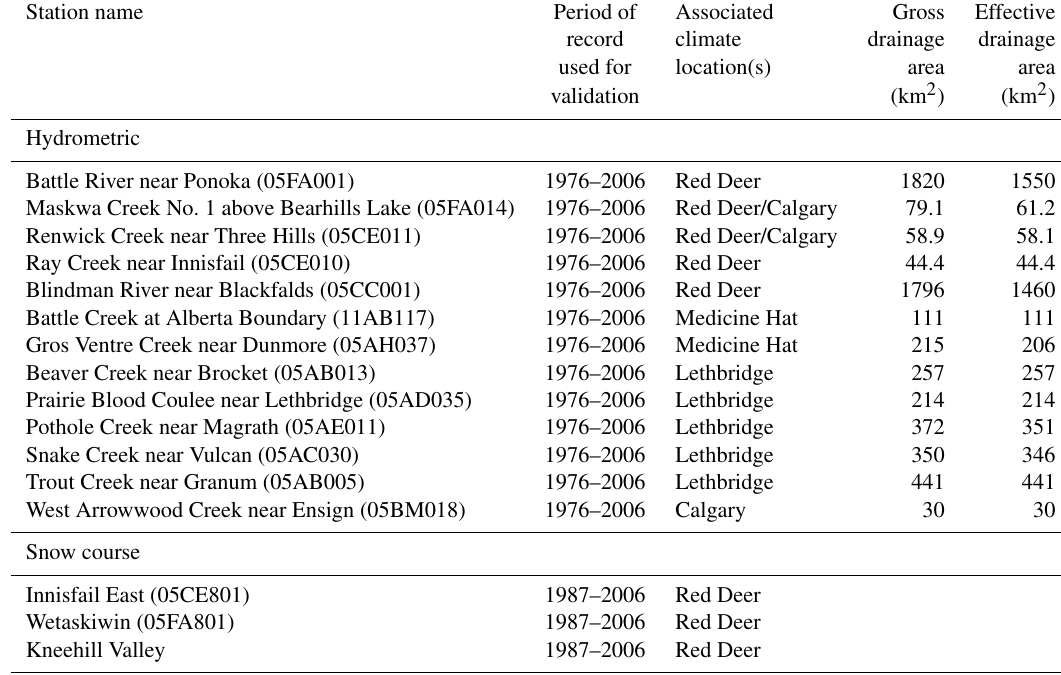
Table 3. Sources of observed data for model evaluation. Water Survey of Canada (WSC) hydrometric data were obtained from the HYDAT database, available at https://collaboration.cmc.ec.gc.ca/cmc/hydrometrics/www/ (last access: 31 March 2022). Effective drainage area is defined by Godwin and Martin (1975) as the drainage area that contributes streamflow to the gauged location during the median annual flood and that was also obtained from HYDAT. The snow water equivalent data were obtained from Alberta Environment and Parks snow